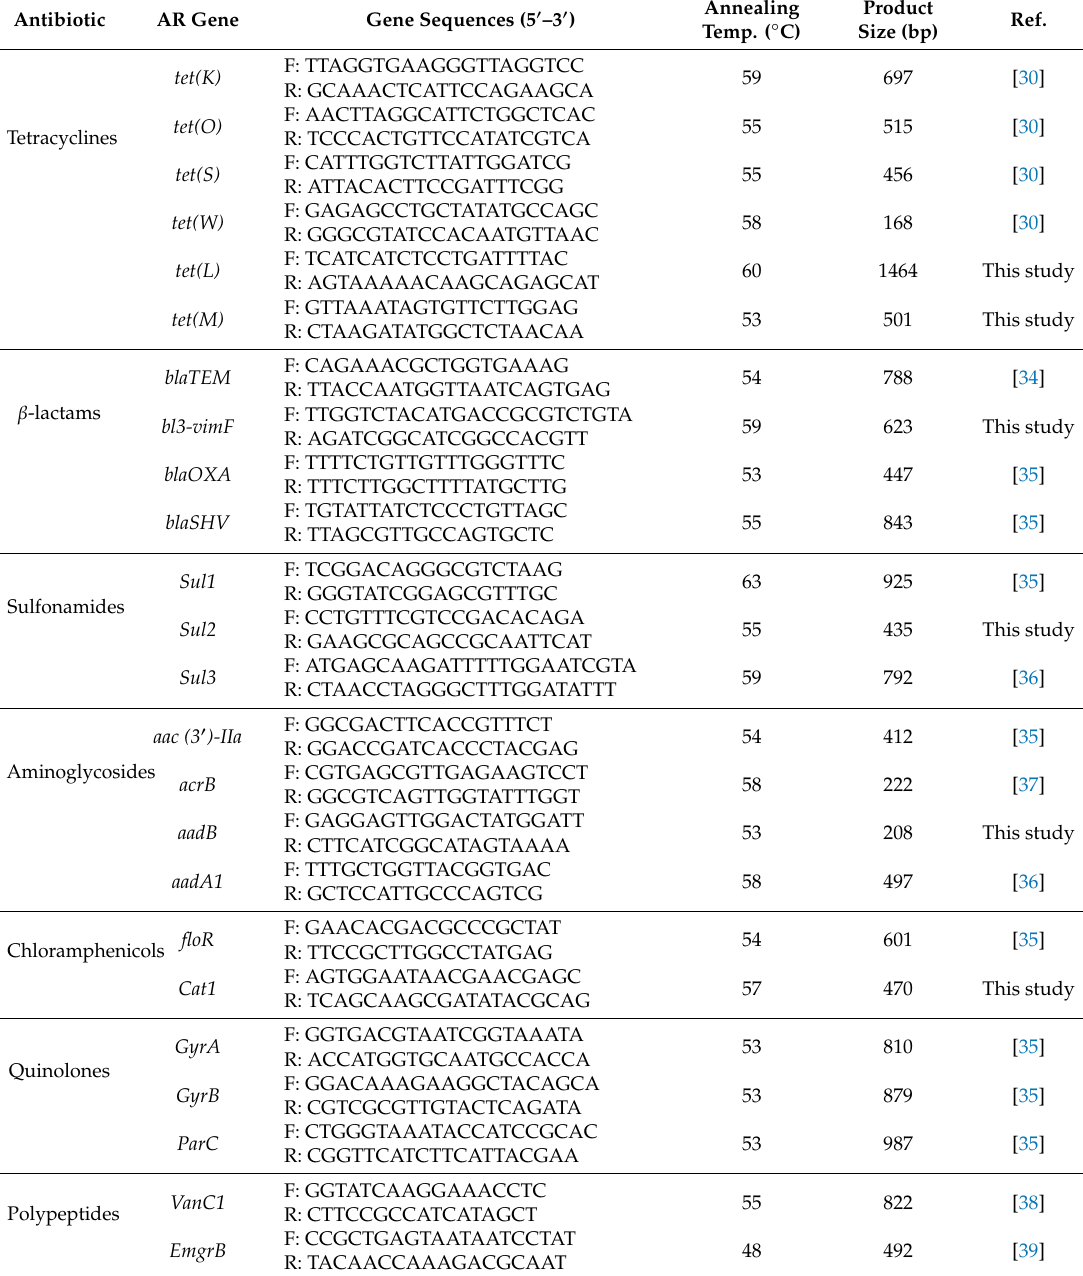
Table 7. Primers sequences of PCR